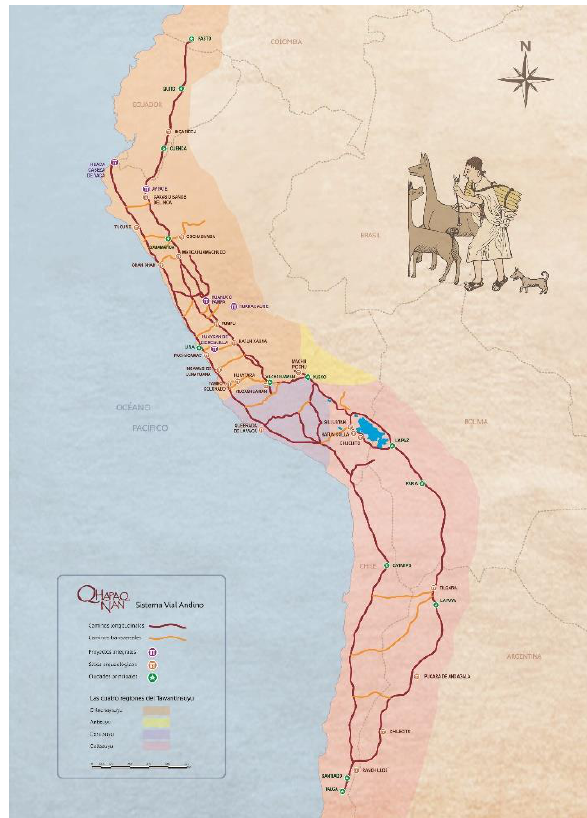
Figure 1. Map of Qhapaq Ñan – Andean Road System. Detail of roads, Projects, Archaeological Sites, Cities and Regions of the Tawantinsuyu. © Project Qhapaq Ñan – Sede Nacional, 2017. Ministerio de Cultura, Gobierno de